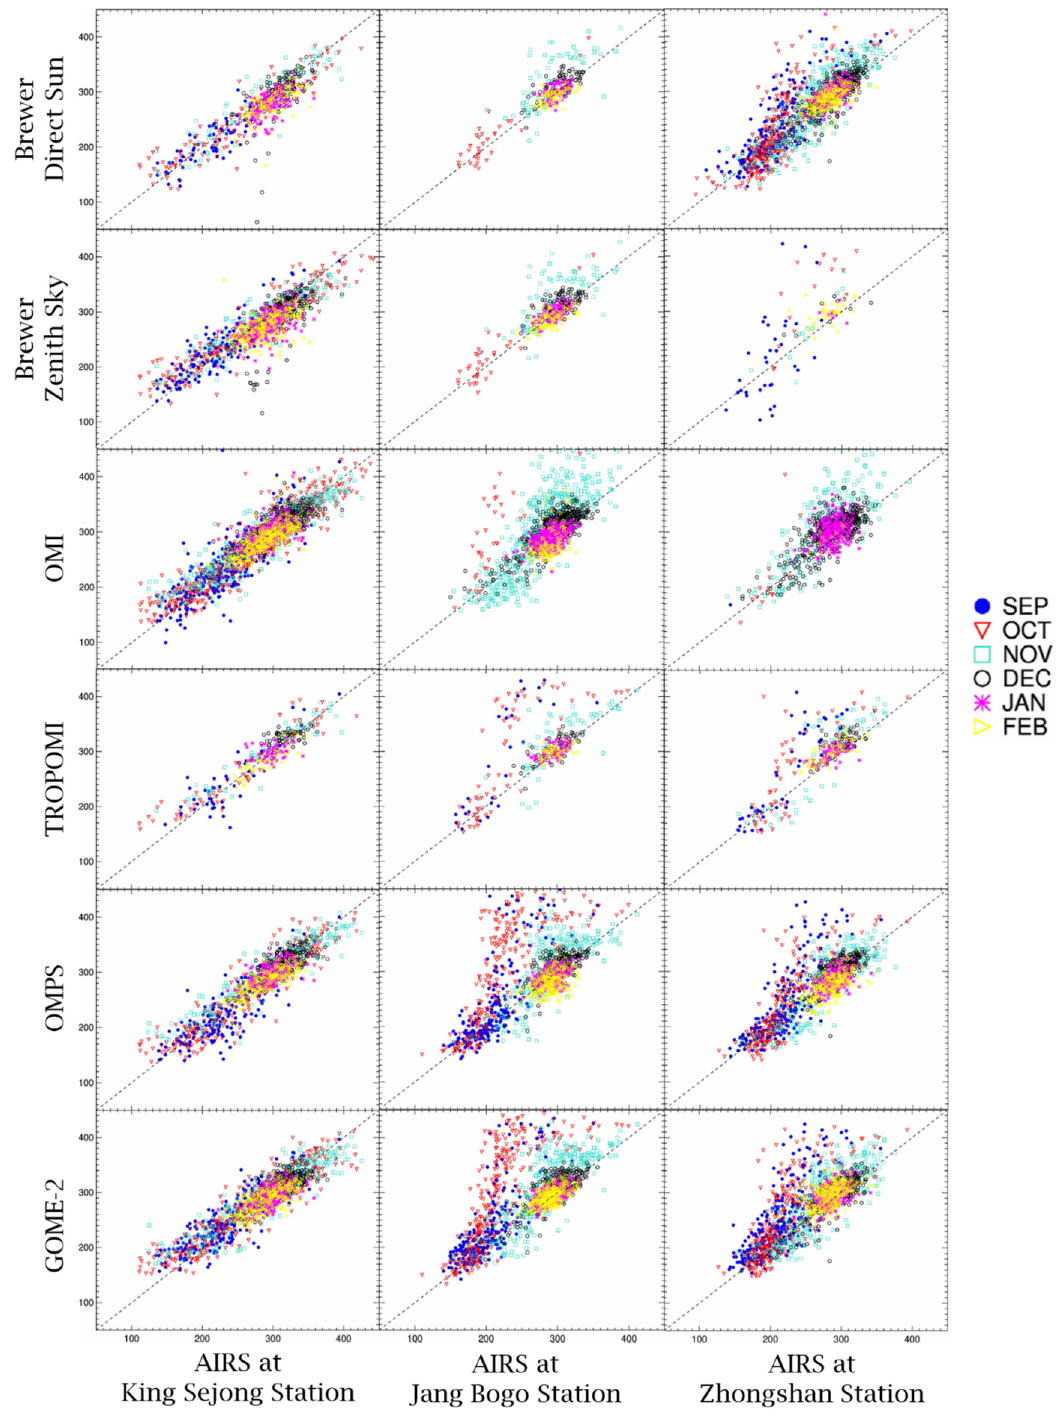
Figure 6. Monthly separated comparison between AIRS Level 2 TOCs and TOCs from the Brewer and satellite measurement at the King Sejong (left); Jang Bogo (middle); and Zhongshan (right) stations. Each month has different color: September (blue); October (red); November (cyan); December (black); January (pink); and February (yellow).